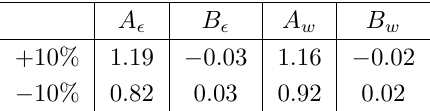
Figure 5 . Expected event ratios for (cid:23) (cid:22) CC events, as a function of true neutrino energy, due to a +10% (red) and (cid:0) 10% (green) variation from the nominal value of the OM photon detection e(cid:14)ciency.